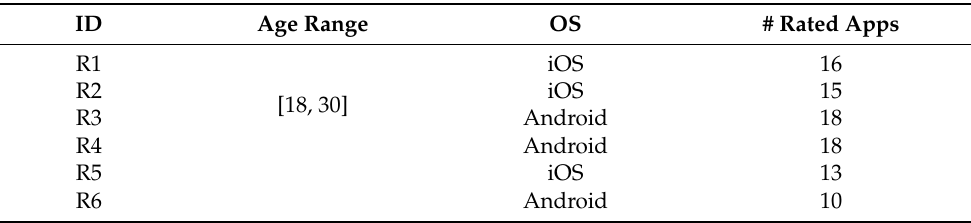
Table 2. Description of subjects that participated in the study as raters. Discriminated age group and